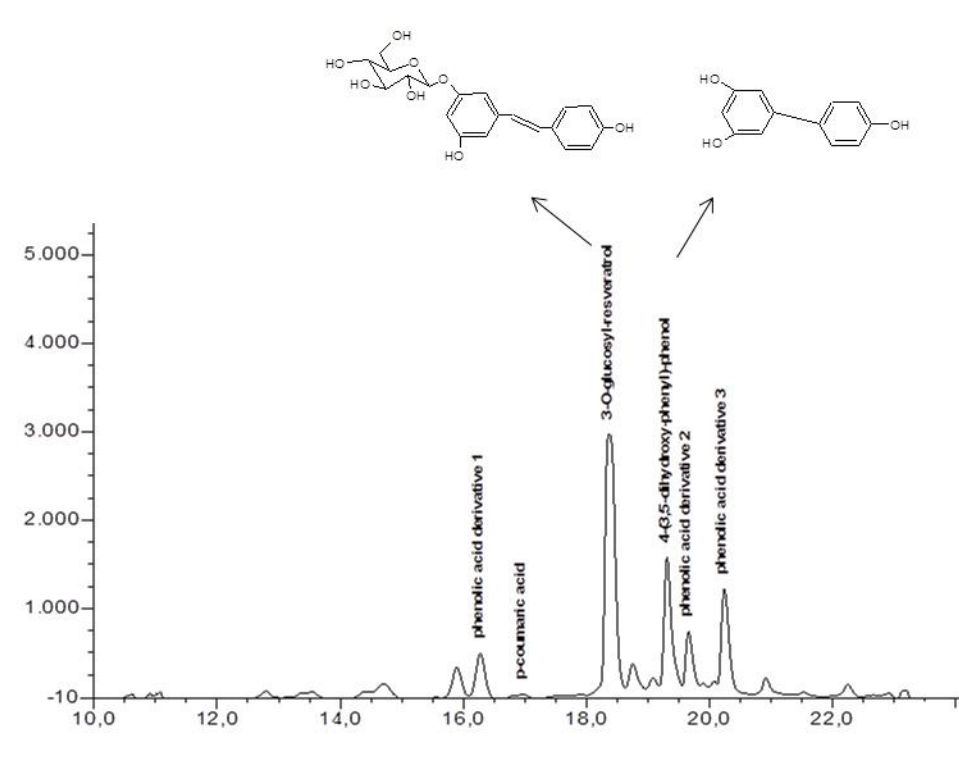
Figure 2. Chemical structures of major resveratrol derivatives identified with the